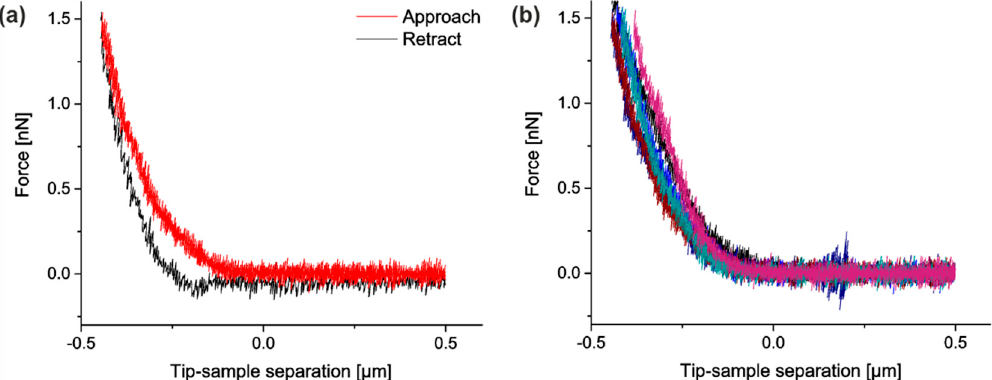
Figure 4. AFM force–distance curves. ( a ) One sample AFM approach (red, color online) and retract (black) cycle recorded above the lamella of a wild-type (WT) cell at 0% stretch. ( b ) Superposition of six AFM force–distance curves recorded successively at the same position above the lamella of a WT cell at 0% strain and intervals of 15 s.